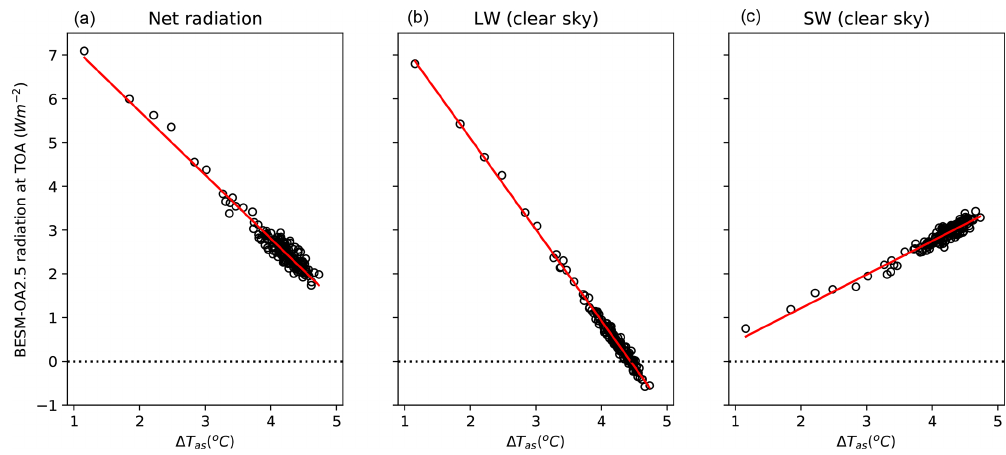
Figure 1. Annual global mean linear regression between (cid:49)T as and (a) net radiation, (b) (cid:49)T as and (cid:49) LW (clear sky), and (c) (cid:49)T as and (cid:49) SW (clear sky) for